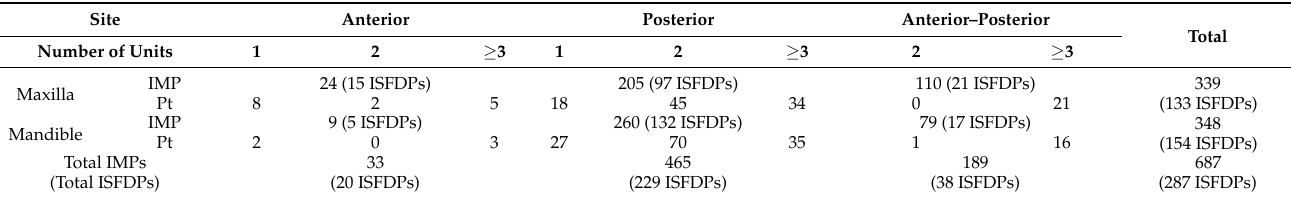
Table 2. Implant distribution.